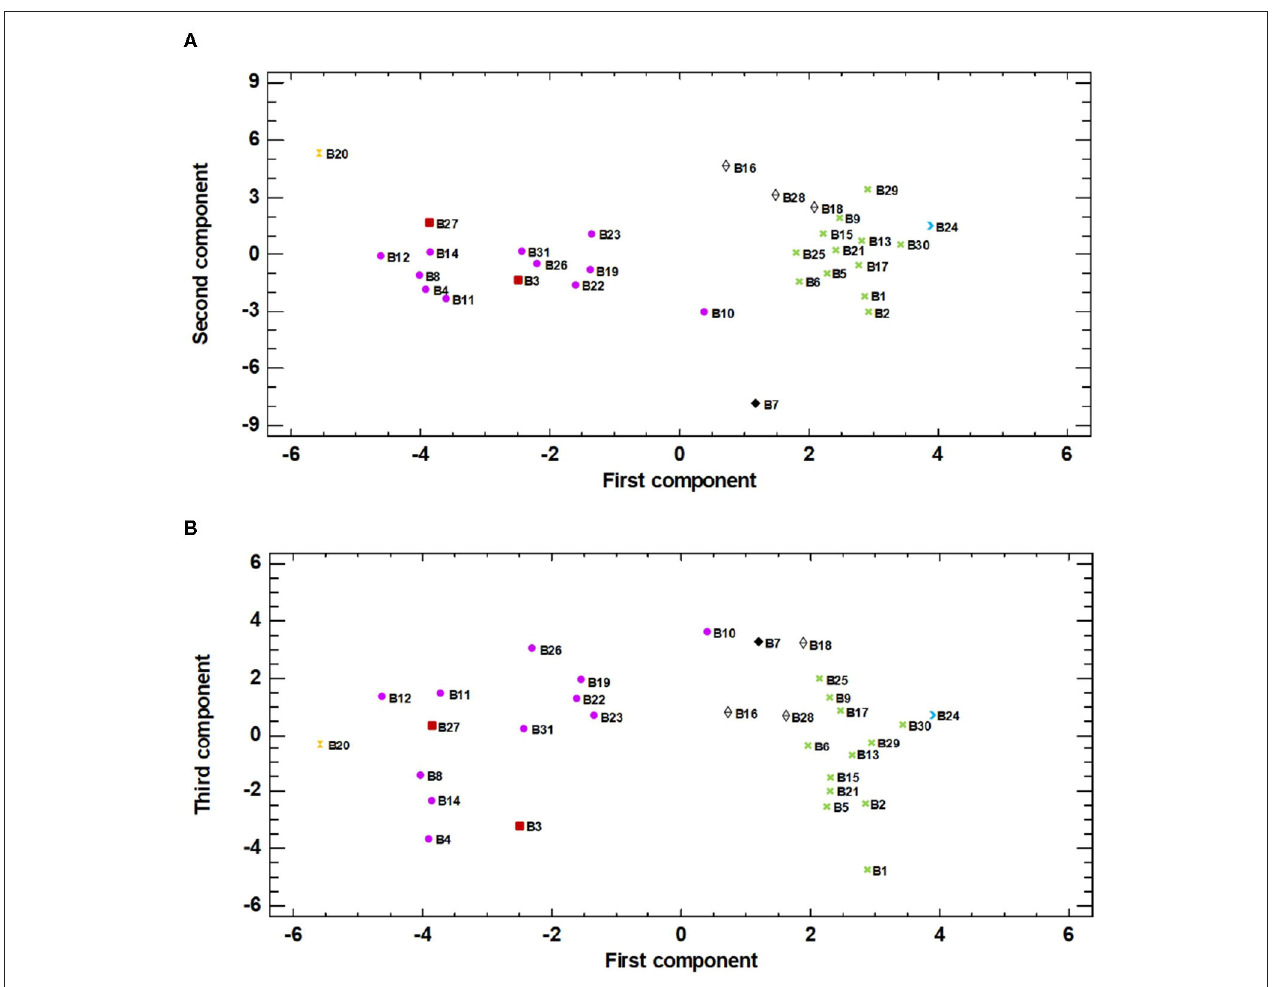
FIGURE 2 | The principal component analysis (PCA) for the 31 eggplant accessions based on the traits used for phenotyping represented in (A) the two first components (first component, X-axis; second component, Y-axis) of the PCA (23.34 and 16.73% of total variation, respectively) and (B) the first and third components (first component, X-axis; third component, Y-axis) of the PCA (23.34 and 12.04% of total variation, respectively). Groups, arranged based mainly on fruit skin colour (G1 black-purple, G2 = striped, G3 = white, G4 = reddish purple), are represented in the plot: G1 ( ), G2 ( ), G3 ( ), and G4 ( ). Outliers B7 ( ), B20 ( ), and B24 ( ) are also expressed in the